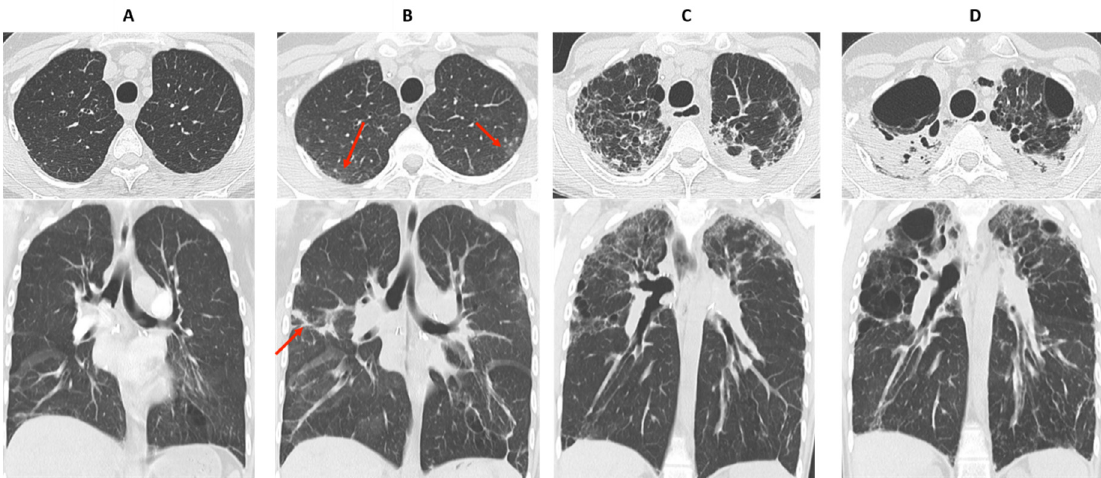
Figure 5. Early detection and evolution of RAS in a 24-year-old man, who underwent bilateral LT in 2007 for cystic fibrosis. Axial and coronal images of CT scans at optimal spirometry ( A ) 4 months before the diagnosis of CLAD ( B ), 8 ( C ) and 22 months ( D ) after the diagnosis of CLAD. ( A ) May 2008: normal CT scan; ( B ) August 2008: first visualization of subtle subpleural ground glass areas and consolidation (red arrows), considered nonspecific and treated with antibiotics. The diagnosis of CLAD was confirmed in December 2008 with a RAS profile; ( C ) August 2009: rapid evolution towards destructive, upper predominant cystic lesions, and interstitial fibrosis; ( D ) October 2010: late RAS. CT changes suggestive of pleuroparenchymal fibroelastosis with dense subpleural fibrosis and pleural thickening; dramatic loss of volume of the upper